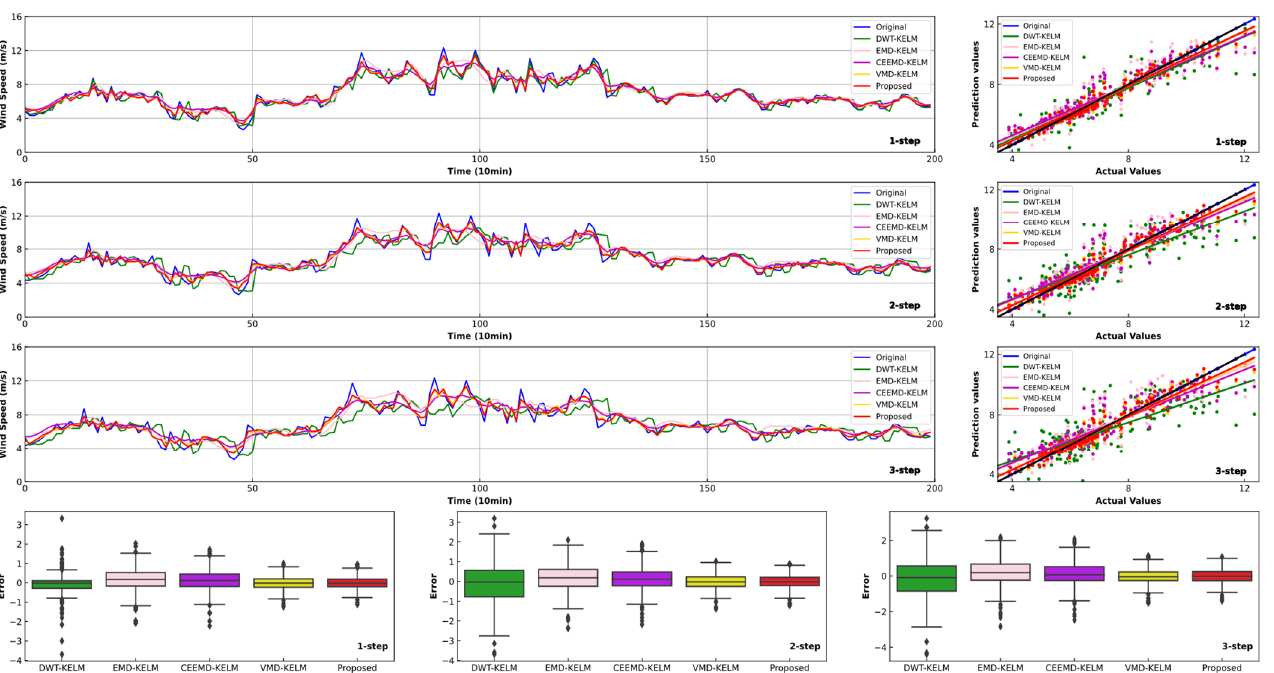
Figure 7. Forecasting performance of decomposed models in one, two and three-step ahead forecasting for the autumn dataset.